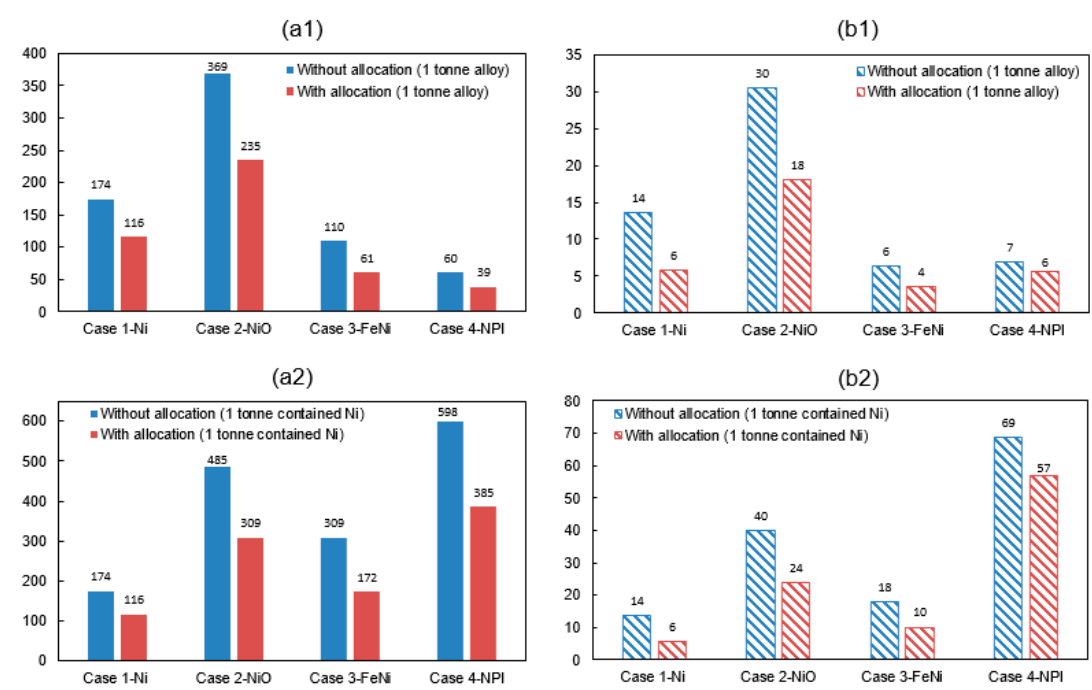
Figure 6. E ff ect of co-product allocation on ( a1 ) Energy consumption (GJ / t alloy), ( b1 ) GHG emissions Figure 6. Effect of co-product allocation on ( a1 ) Energy consumption (GJ/t alloy), ( b1 ) GHG emissions (tCO 2 -eq / t alloy) ( a2 ) energy consumption (GJ / t contained Ni) and ( b2 ) GHG emissions of nickel product (tCO 2 -eq/t alloy) ( a2 ) energy consumption (GJ/t contained Ni) and ( b2 ) GHG emissions of nickel (tCO 2 -eq / t contained Ni) (allocation based on proposal in Table product (tCO 2 -eq/t contained Ni) (allocation based on proposal in Table 11).